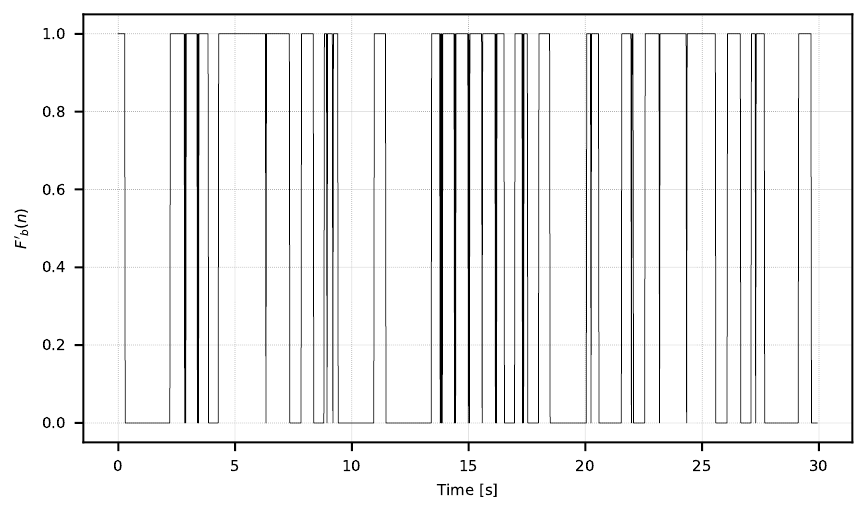
Figure 10. Received binary signal F (cid:48)